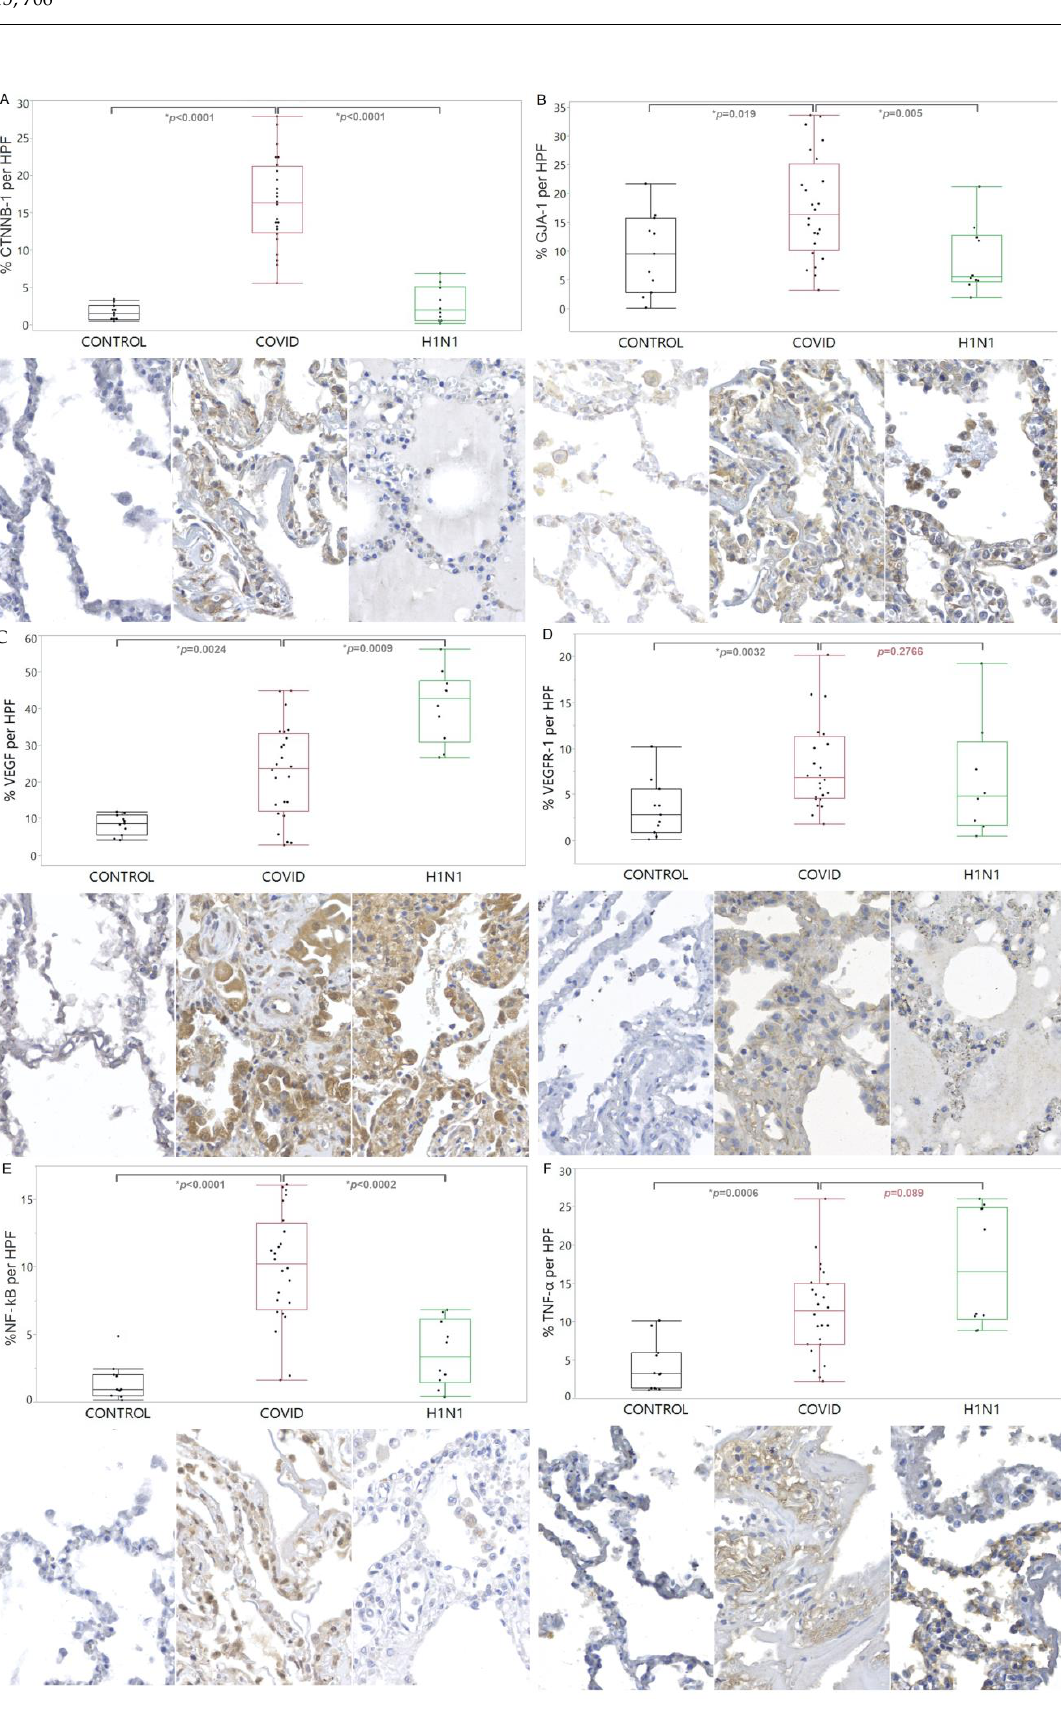
Figure 3. Comparison of the levels of CTNNB-1 ( A ), GJA-1 ( B ), VEGF ( C ), VEGFR-1 ( D ), NF-kB ( E ), and TNF- α ( F ) proteins in tissue samples from COVID-19 patients versus control and